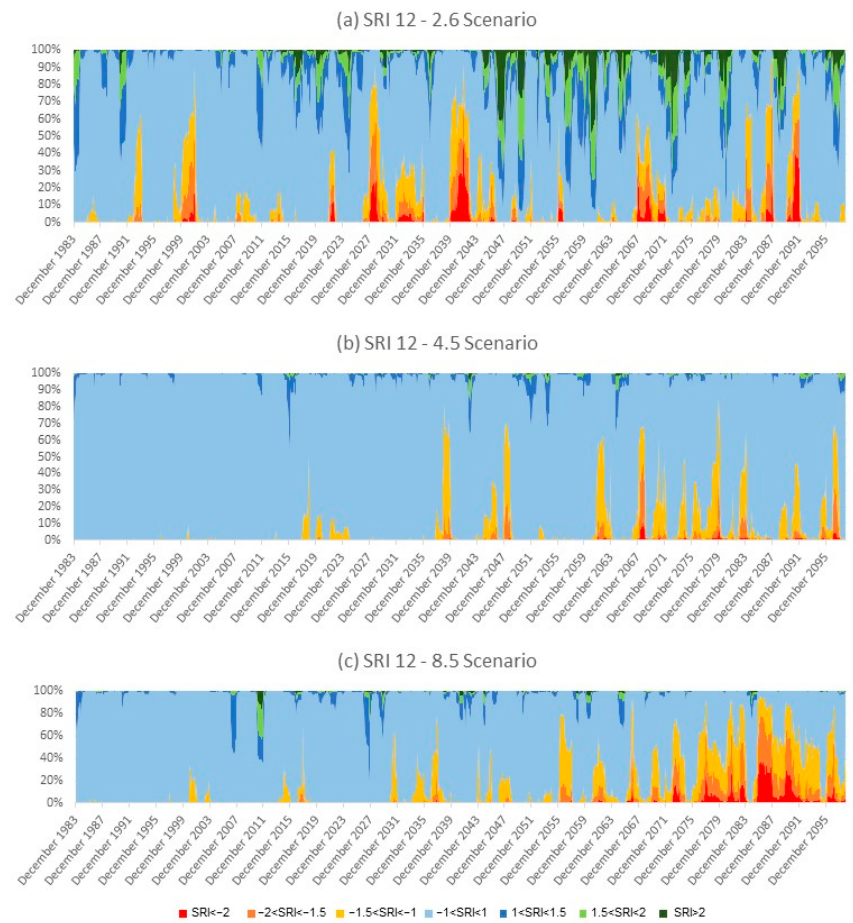
Figure 3. Temporal distribution of SRI 12 index as a percentage of Crete under each RCP2.6 ( a ), RCP4.5 ( b ) and RCP8.5 ( c ) categories.